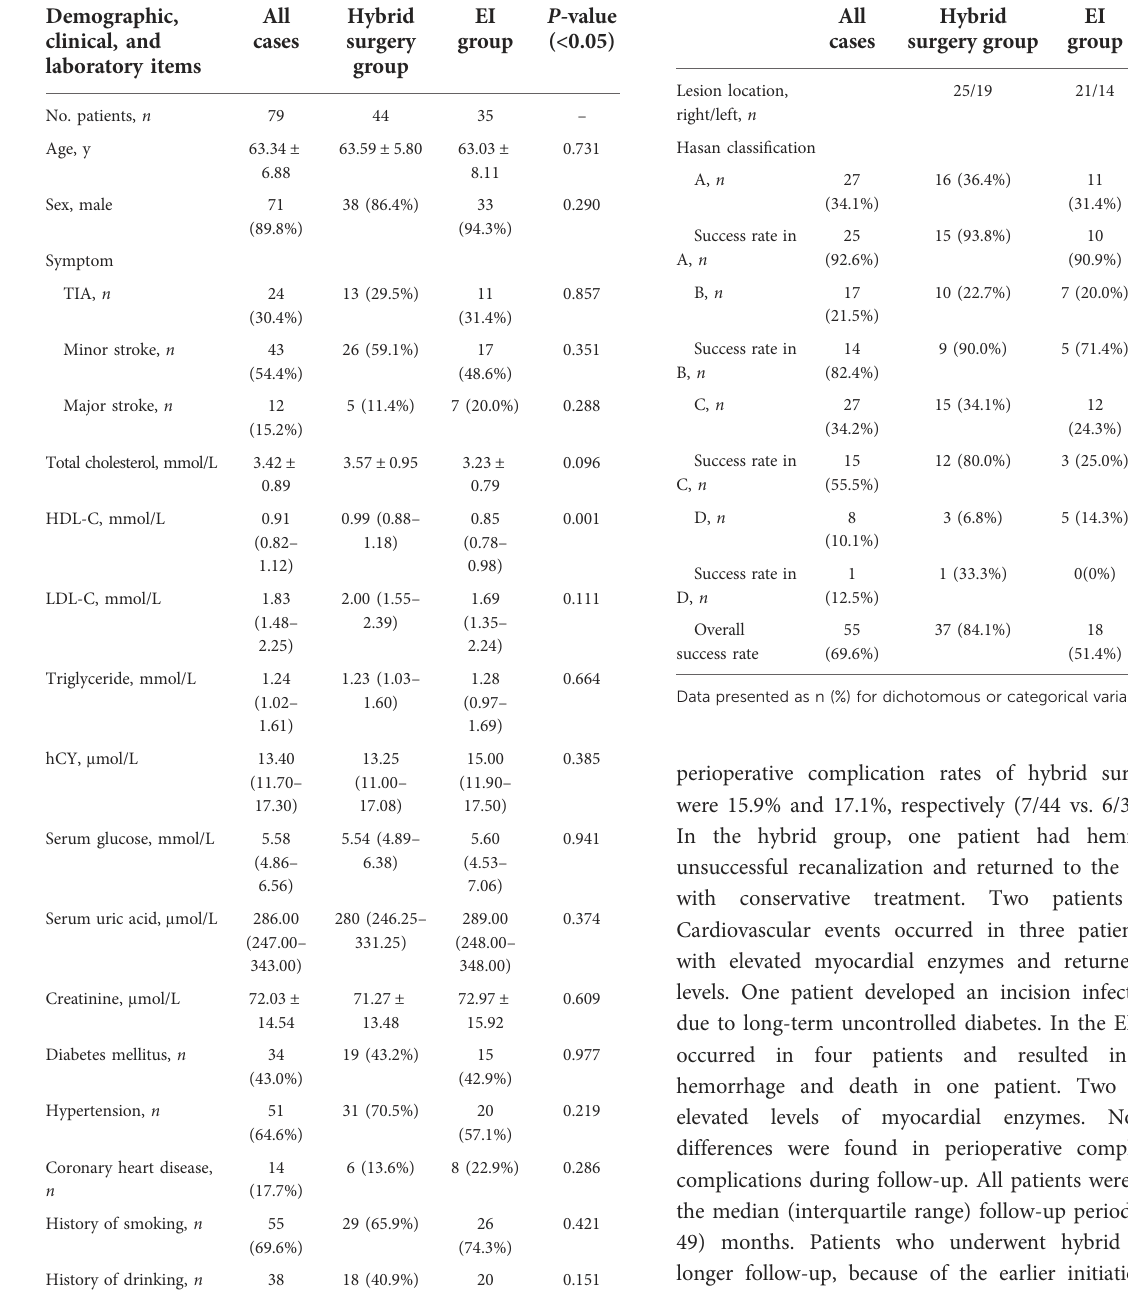
TABLE 1 Baseline characteristics of study participants. TABLE 2 Lesion characteristics and technical success